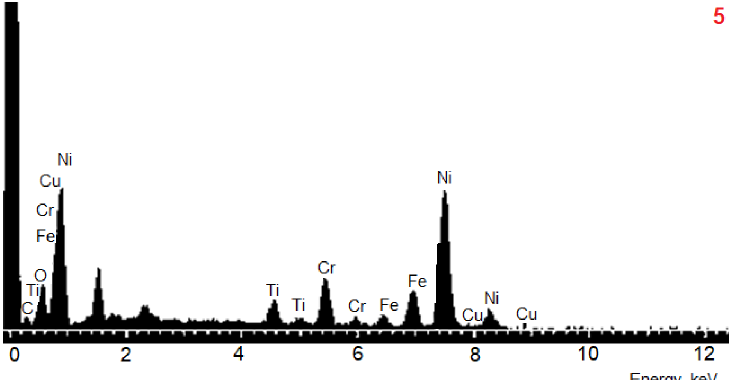
Figure 9. Energy dispersive spectrum of an intermetallic iron alloy from the magnetic phase of the upper soil horizon of the Urbic Technosol Loamic, Eutric in the residential zone of Gubakha (0–10 cm layer).